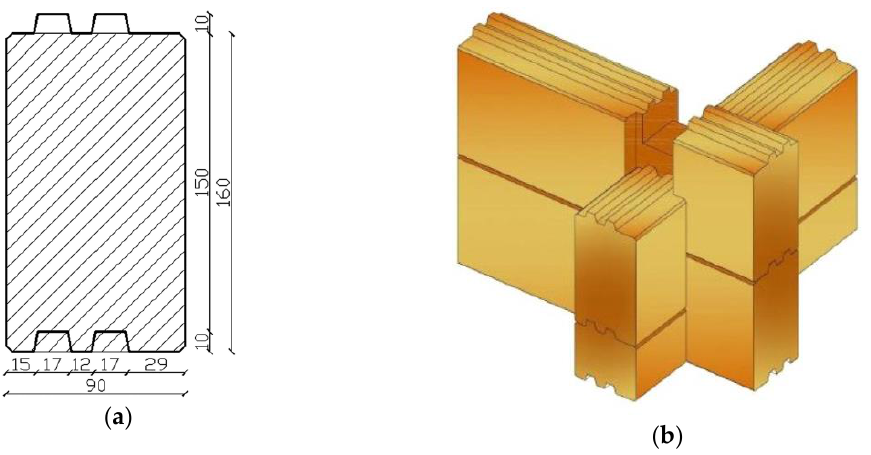
Figure 1. Reference timber log and joint (www.haus.rubner.com), with evidence of ( a ) cross-sectional geometry (nominal dimensions are given in mm) and ( b ) Standard, saddle notch, corner joint specimen.